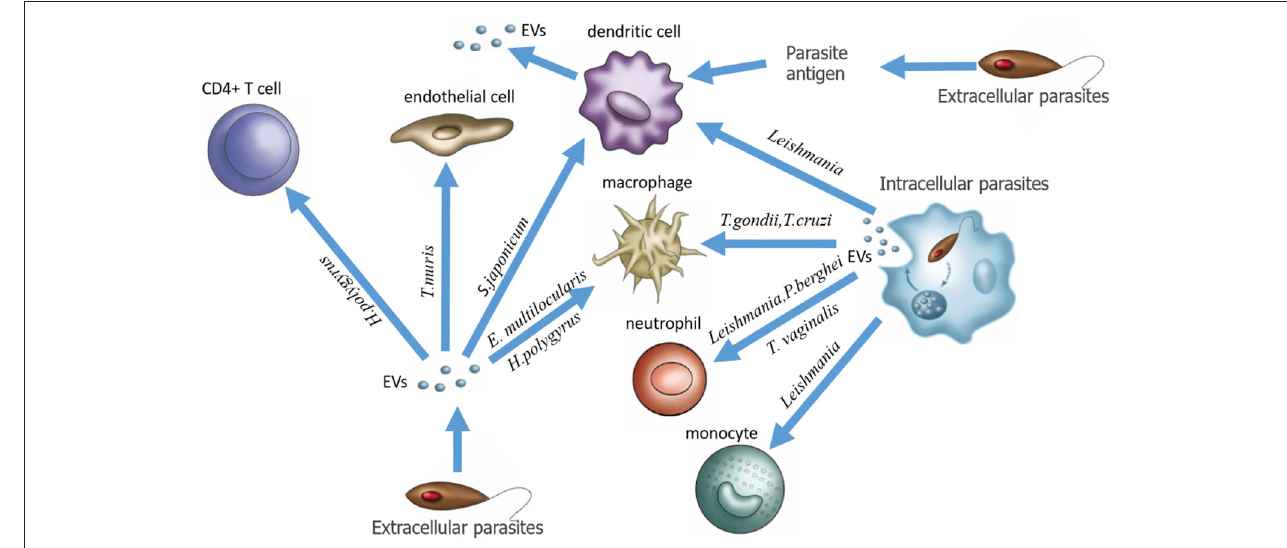
FIGURE 1 | Three EV production modes associated with parasitic